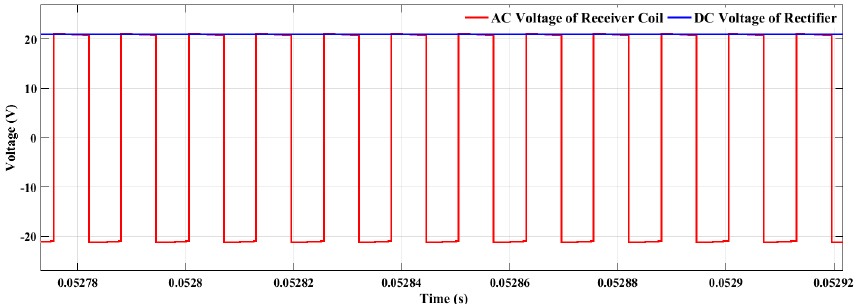
Figure 3. Simulated voltage output of receiver coil and rectifier.